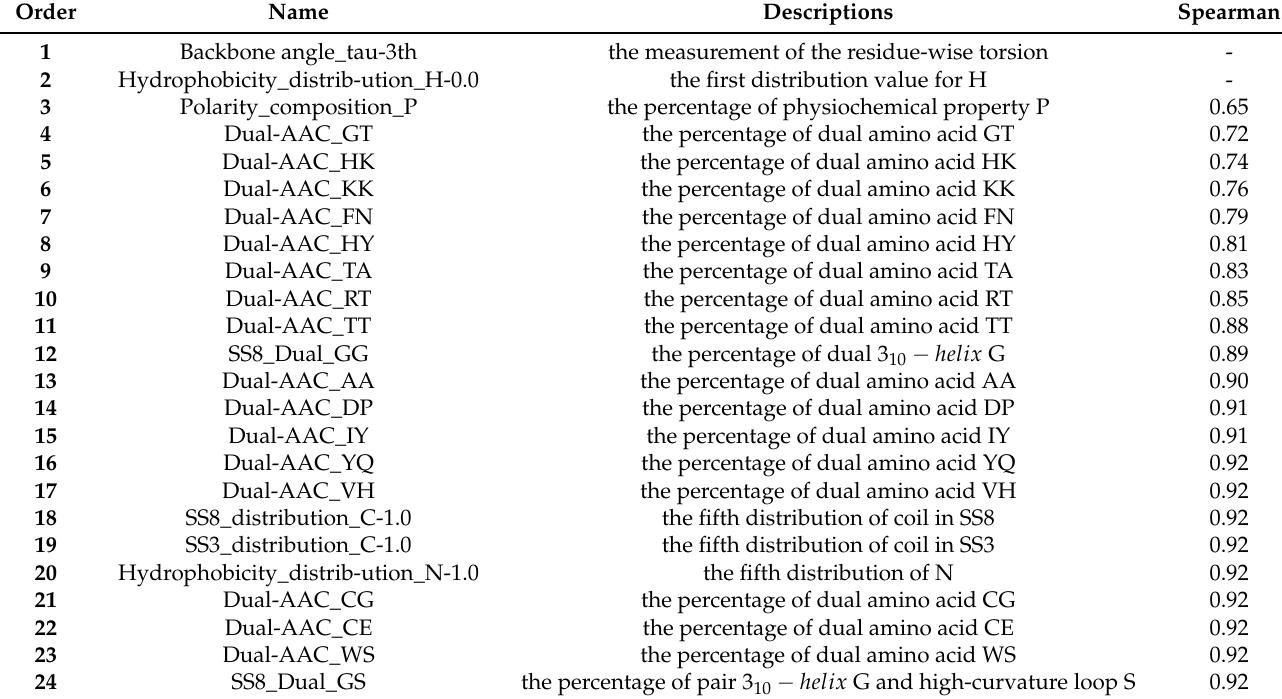
Table 1. Order, names, and brief descriptions of the foremost 24 features selected by using the forward searching strategy with the performance of the corresponding prediction model measured by using the Spearman’s correlation